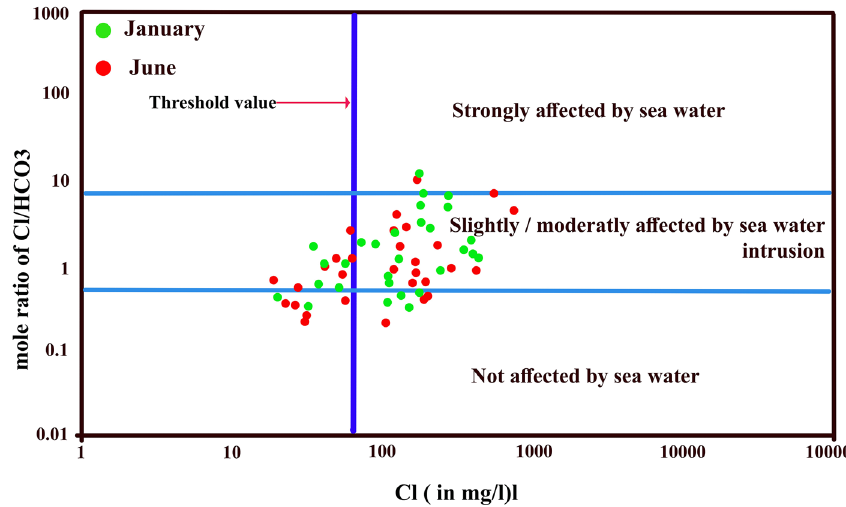
Fig. 13 Molar ratios of Cl − / HCO 3− versus Cl −